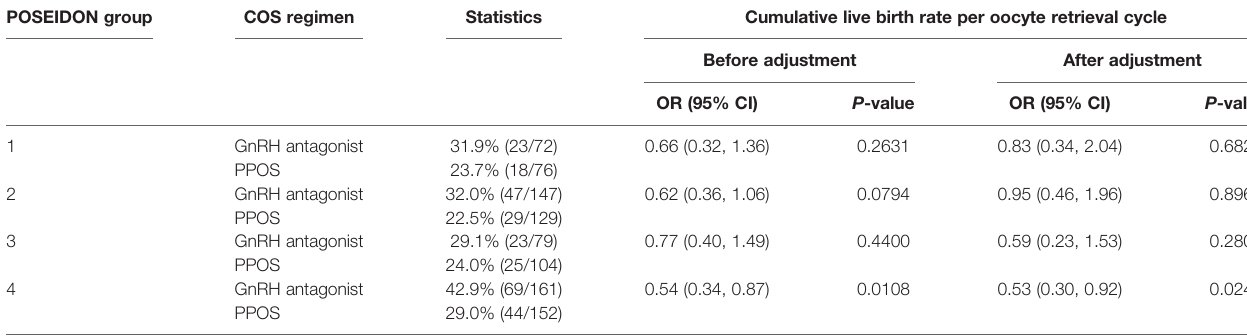
TABLE 4 | Multivariate logistic regression analysis results of the cumulative live birth rate per oocyte retrieval cycle by COS regimen and Poseidon